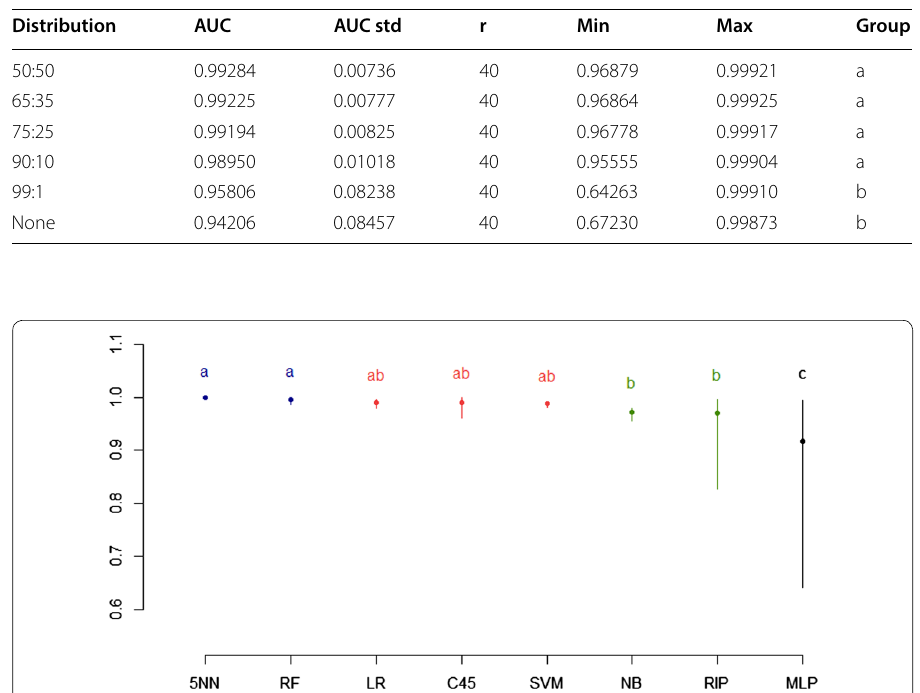
Fig. 4 Tukey’s HSD groupings by learner